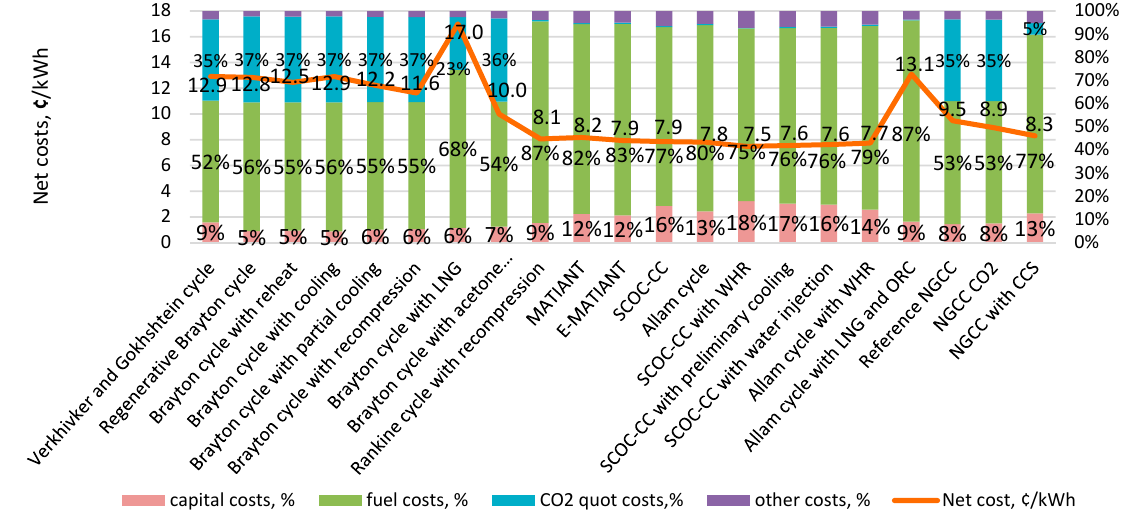
Figure 32. Cost of electric power generated with regeneration CO 2 power cycles in comparison with NGCC.